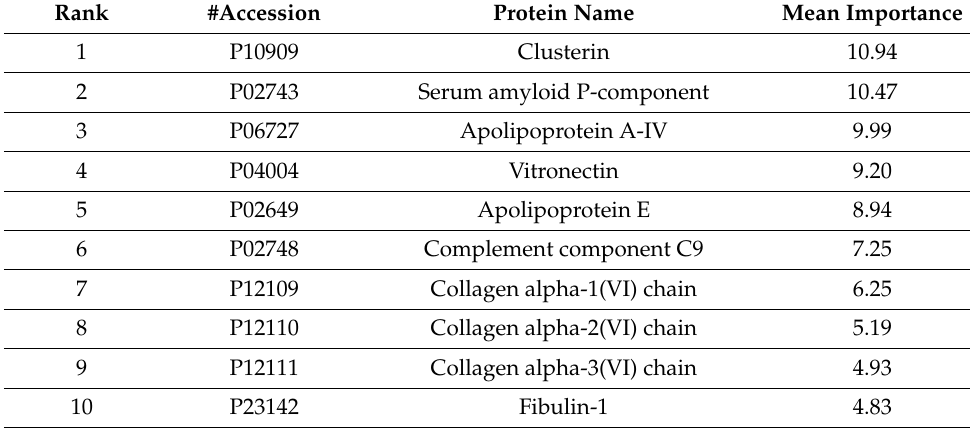
Table 1. Signature proteins for amyloid deposits. The Boruta feature selection method was applied to estimate the capacity of specific proteins to differentiate between Congo Red-positive and negative samples determined by the calculated “mean importance score “. The quantitative readout from the proteomic analysis (number of peptide spectrum matches for each protein) of the 153 biopsies divided into a training set (70% of the biopsies randomly chosen among CR+ and CR − samples) and a test set (30% of the biopsies randomly chosen among CR+ and CR −